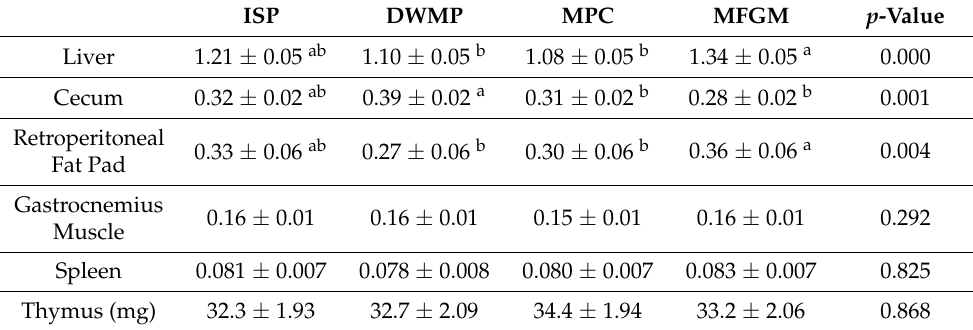
Table 3. Organ Weights.